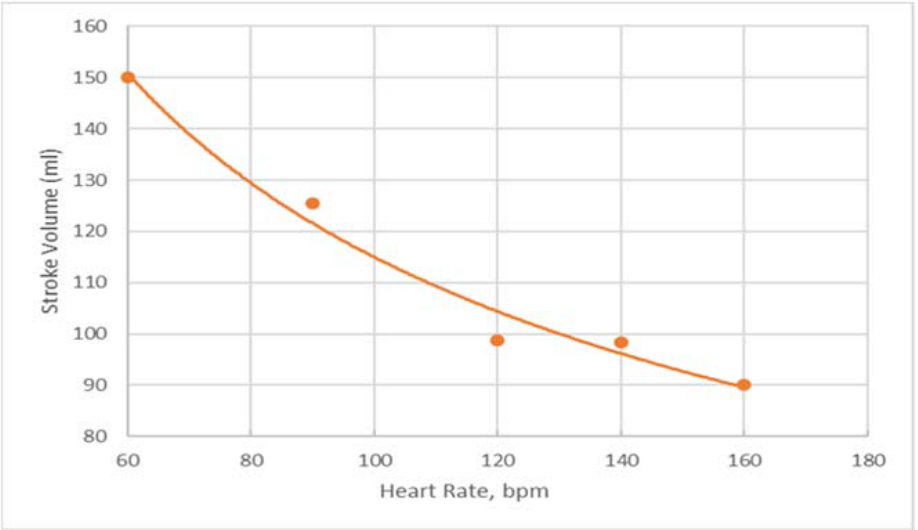
Figure 4. Predictions of stroke volume for paced heart for heart rates of 60, 90, 120, 140 and 160 bpm in orange dots with a trendline fitting the data in orange line.